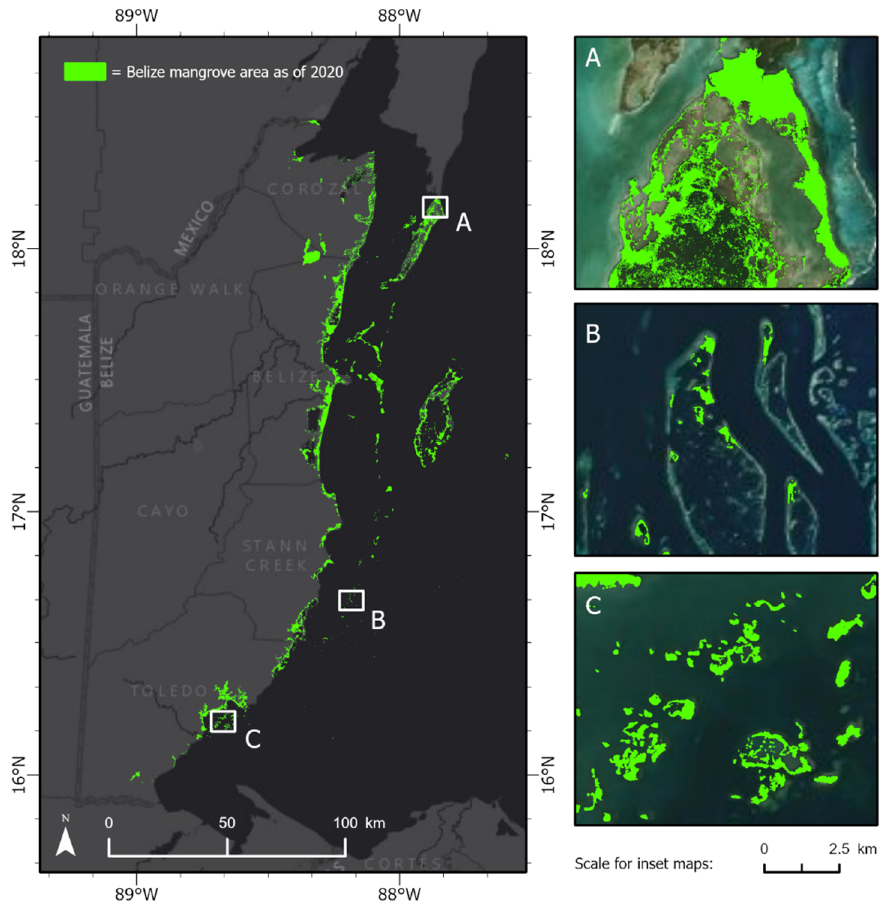
Figure 2. Mangrove area in Belize as of 2020. Insets provide more detailed images of mangrove cover in ( A ) Bacalar Chico National Park and Marine Reserve, ( B ) South Water Caye Marine Reserve, and ( C ) Port of Honduras Marine Reserve.